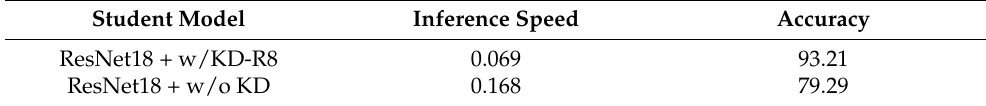
Table 8. Scenario 1: Inference speed and accuracy of a CNN classifier on an embedded